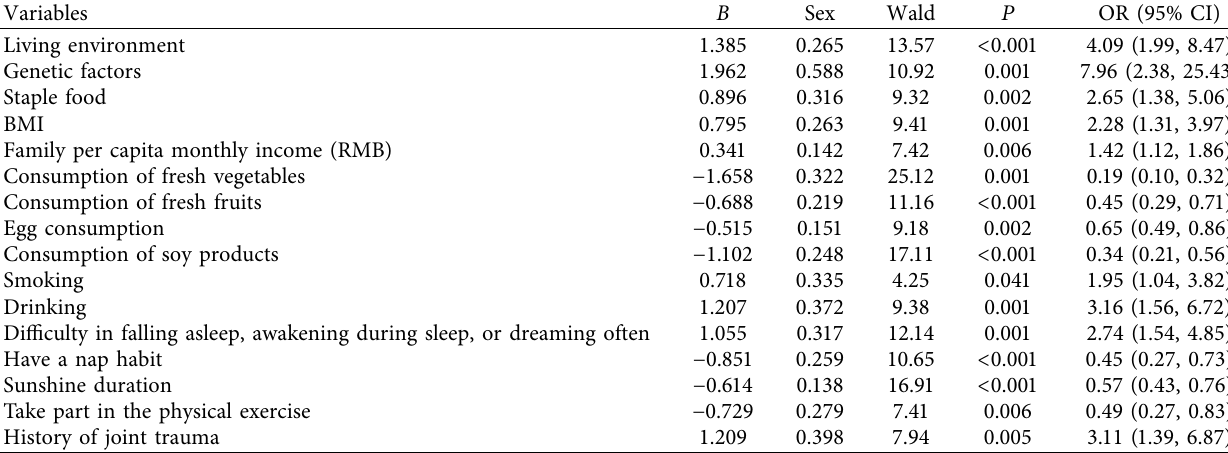
Table 2: Logistic analysis of univariate conditions affecting